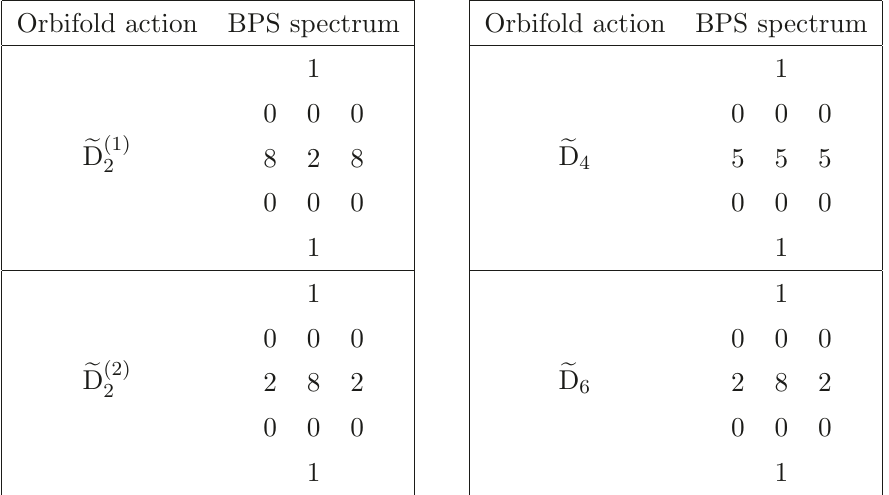
, 1 , 3 , 2 } with p + q ∈ N 0 2 2